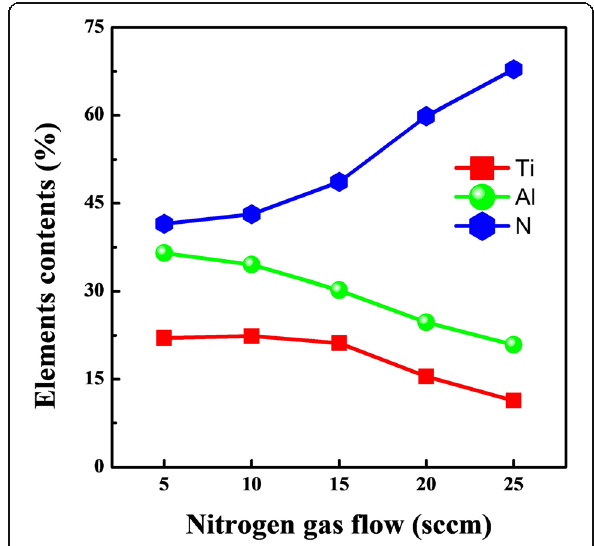
Fig. 1 Element contents of Ti-Al-N films fabricated at various nitrogen gas flow rates